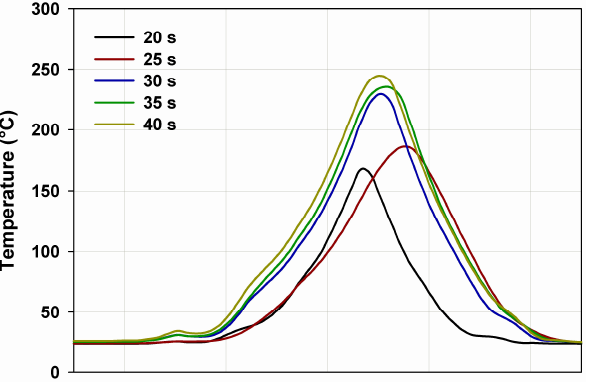
Figure 13. Temperature (T 1 ) along the free burning sample 1 (BPA.DM-NVP-0).